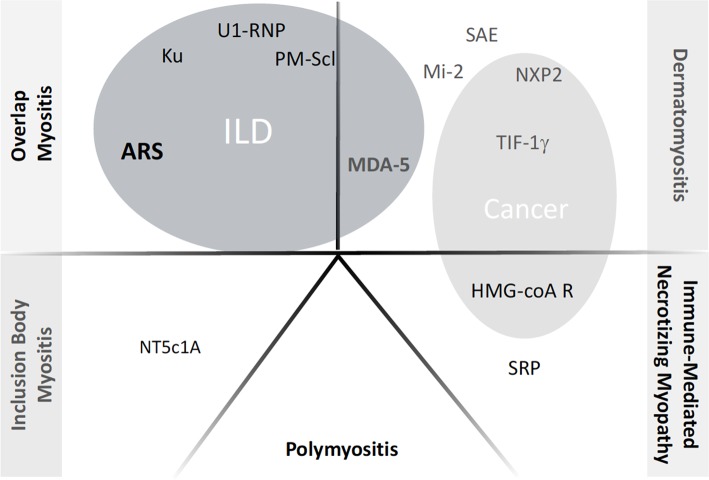
Current classification of inflammatory myopathies and the respective autoantibodies. ILD, Interstitial Lung Disease; ARS, anti-tRNA-antisynthetase autoantidodies, including anti-Jo-1, PL7, PL12, OJ, EJ, Zo, KS, YRS. NXP2: example of myositis specific autoantibody or myositis associated autoantibody; when appearing inside gray circles, the autoantibodies have been shown to correlate with occurrence of either ILD or Cancer, respectively.